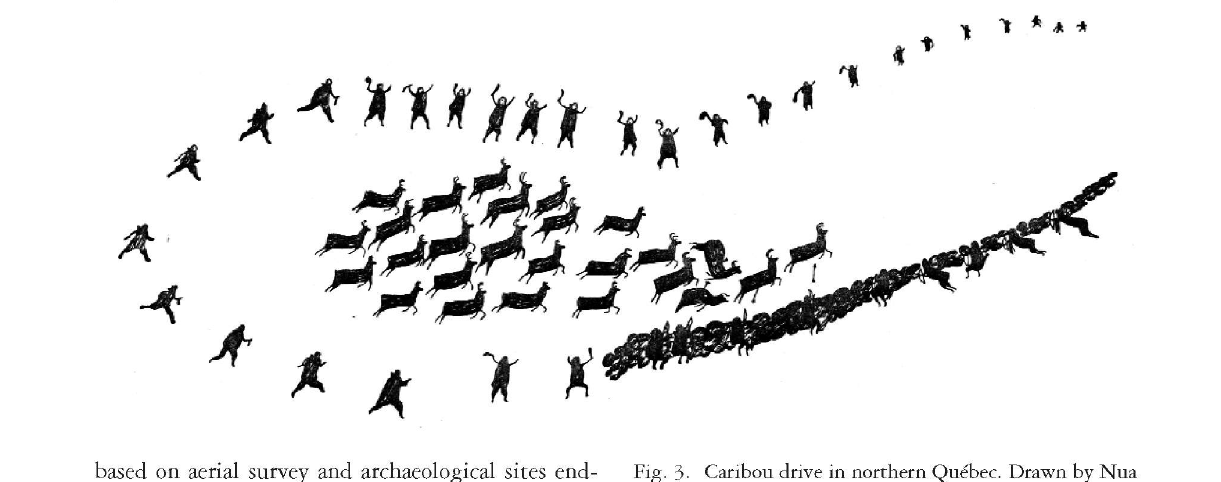
Fig. 3. Caribou drive in northern Québec. Drawn by Nua